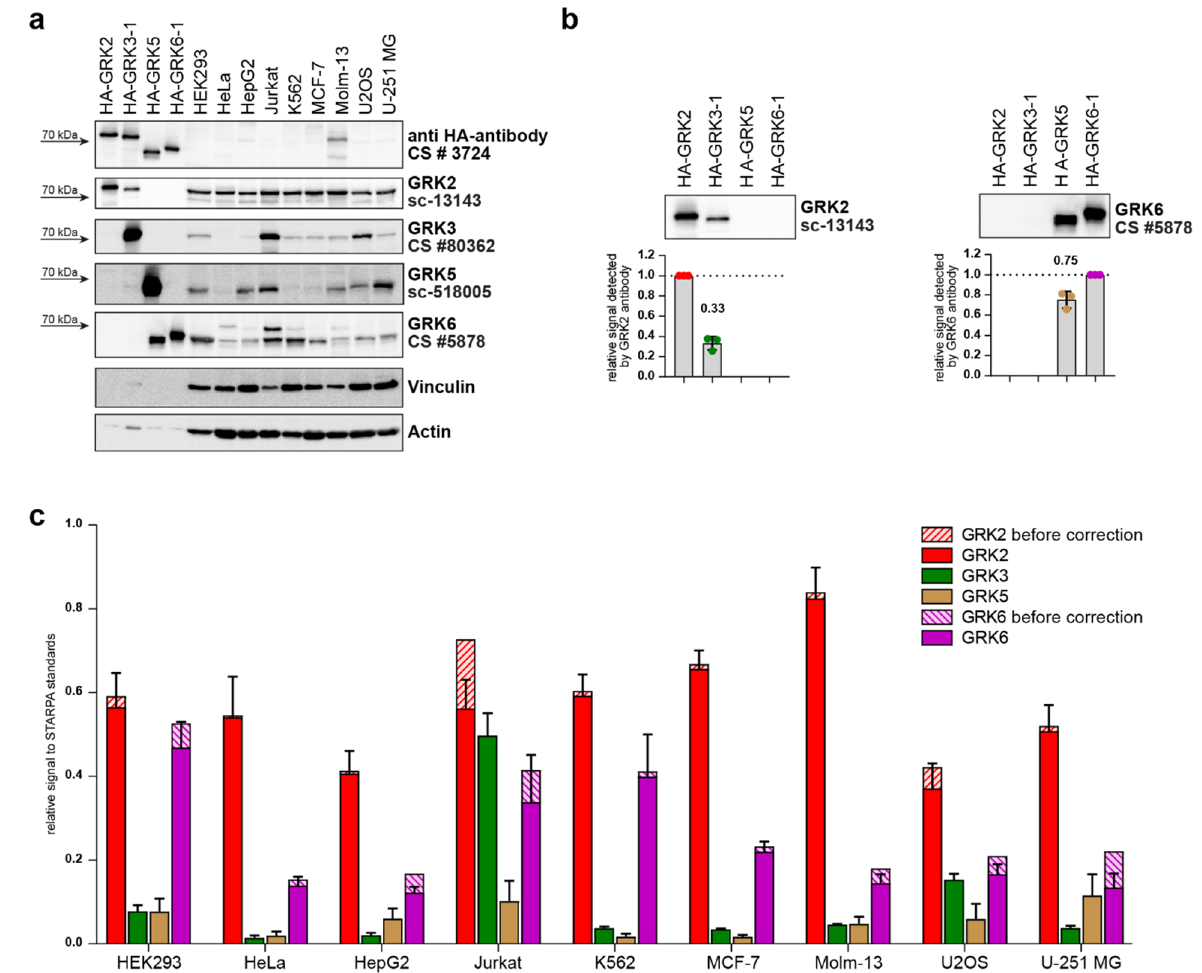
Figure 5. STARPA reveals differential GRK expression in commonly used cell lines. ( a ) STARPA was used to determine relative GRK expression in HEK293, HeLa, HepG2, Jurkat, K562, MCF-7, Molm-13, U2OS, and U-251 MG cells. Lysates of different cell lines together with the validated STARPA standards (Figure 4c,d) were loaded onto polyacrylamide gels. Western blot analysis using anti-HA antibody confirmed the STARPA standards. Immunoblotting using anti-GRK antibodies for each isoform allowed the determination of endogenously expressed GRK levels in the cell lines. Shown are representative images of three independent blots from identical lysates. ( b ) Close ups of the STARPA standards from the immunoblot presented in ( a ) displaying the cross-reactivity of the anti-GRK2 and anti-GRK6 antibody towards GRK3 and GRK5, respectively. Below, the quantification of three independent blots ±SD. The means of the obtained signals are indicated and were used to determine the respective cross-reactivity coefficient of the antibodies. ( c ) STARPA blots were quantified according to each GRK isoform-specific antibody, and the relative signal compared to the respective signal in the standards is shown as mean + SD of three independent blots from identical lysates. The calculated relative expression levels of GRK2 and GRK6 before (striped) and after (solid) cross-reactivity correction are presented.